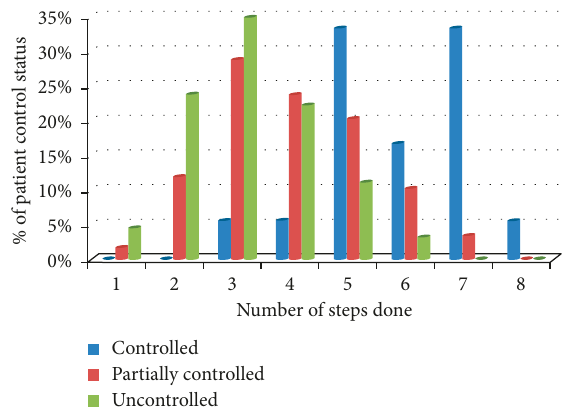
Figure 4: The relationship between number of steps done and asthma control status, respiratory clinic, JUMC, Ethiopia,